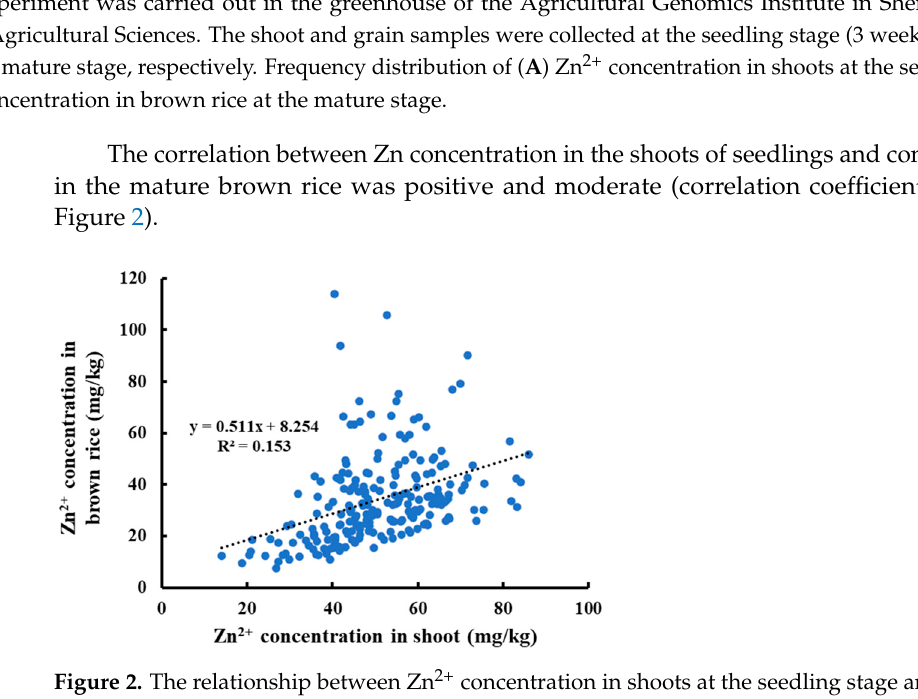
Figure 2. The relationship between Zn 2+ concentration in shoots at the seedling stage and in grains at the mature stage in the DC1 at the mature stage in the DC1 population.